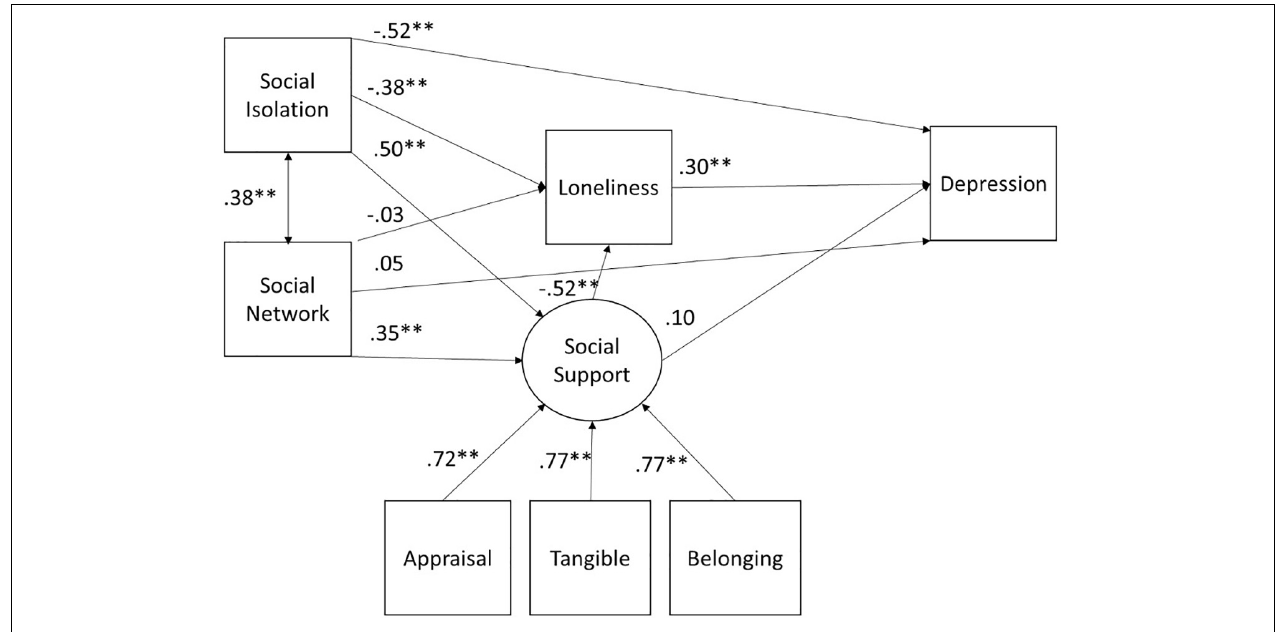
FIGURE 1 | SEM for depression for the full sample. All paths are denoted with the standardized beta. ∗ p < 0.05, ∗∗ p <